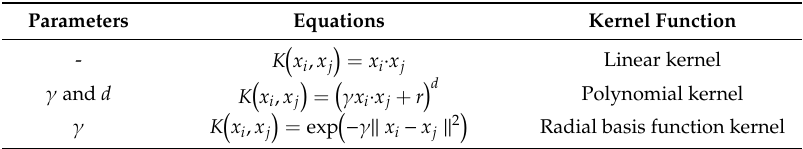
Table 1. Equations of di ff erent kernel